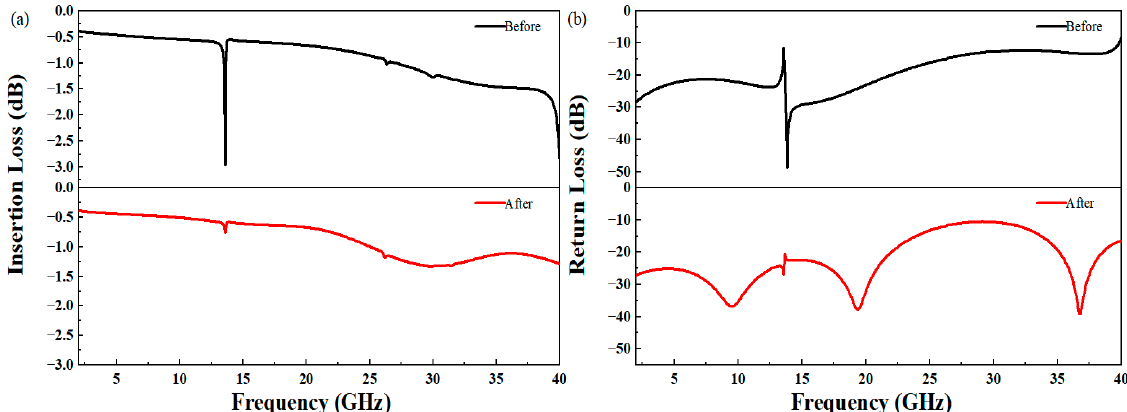
Figure 4. Simulation results before and after optimization for the TTDL unit: ( a ) insertion loss (S 21 ), ( b ) return loss (S 11 ).